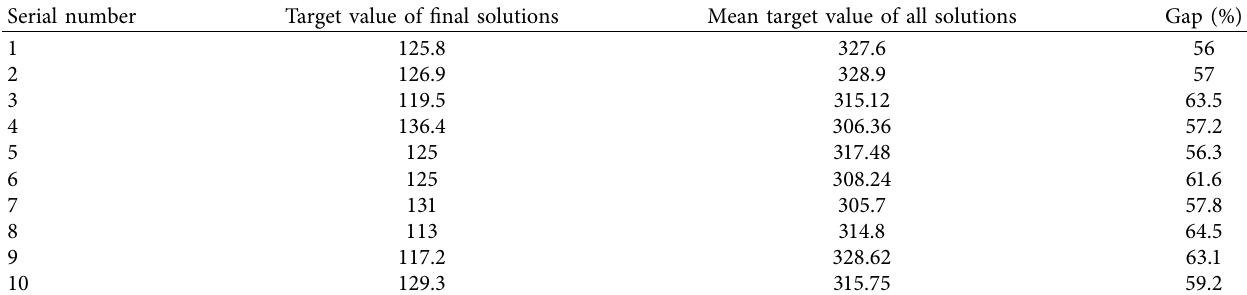
Table 12: Mean target values of all solutions and the target values of the final solutions.